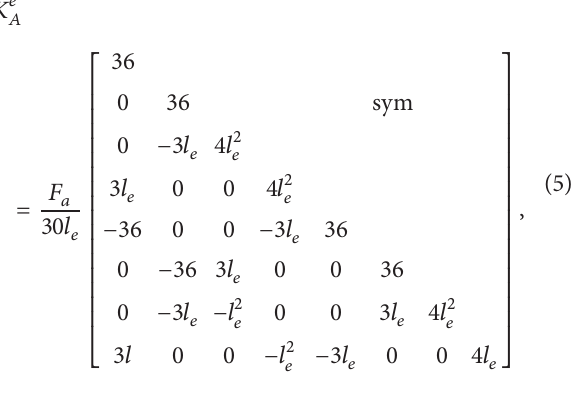
Figure 2. The rotations 𝜃 and 𝜓 are small in a gear pair;